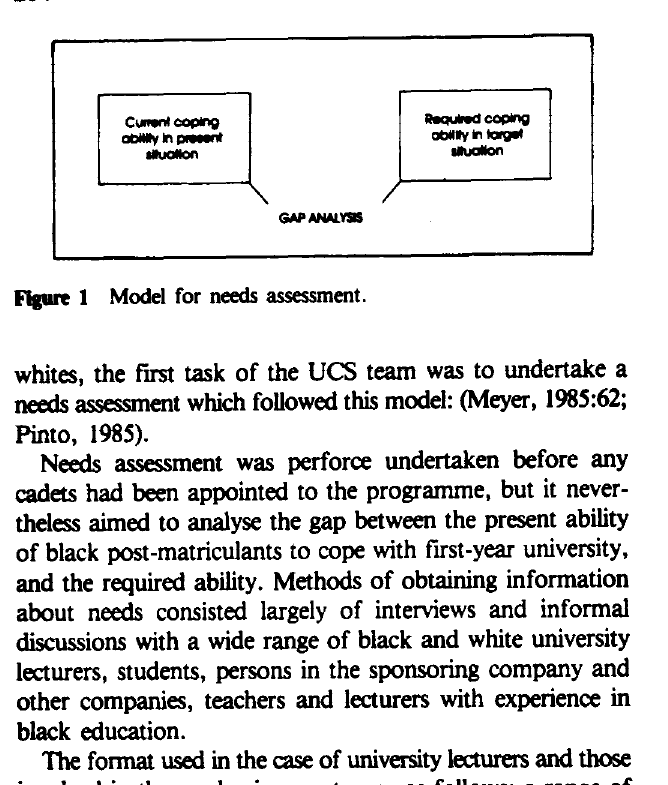
Flpre 1 Model for needs